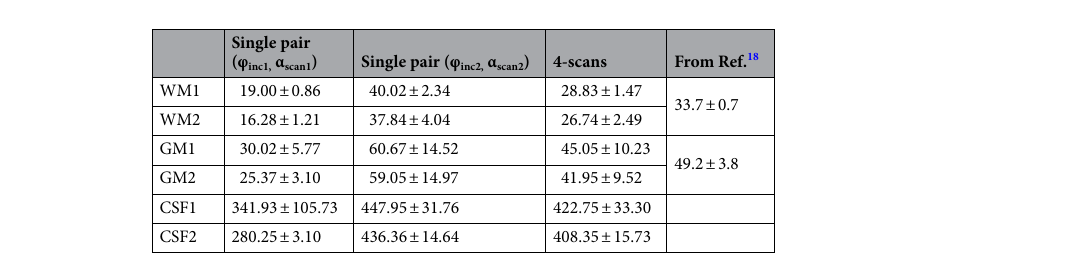
Table 1. Estimated T 2 in sample regions of white matter, grey matter and CSF (see Fig. 4).